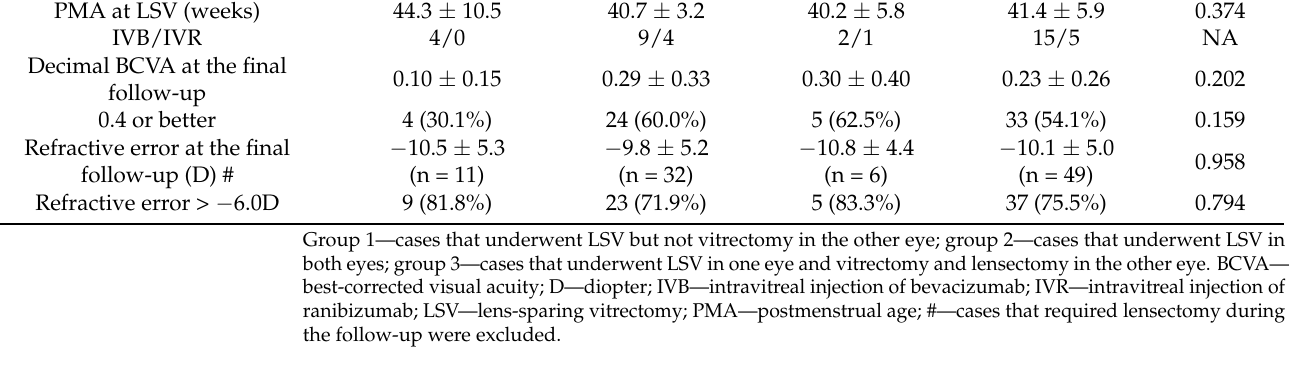
Table 3. Comparison of ocular characteristics between eyes that received anti-VFGF therapy and those with no history of anti-VFGF